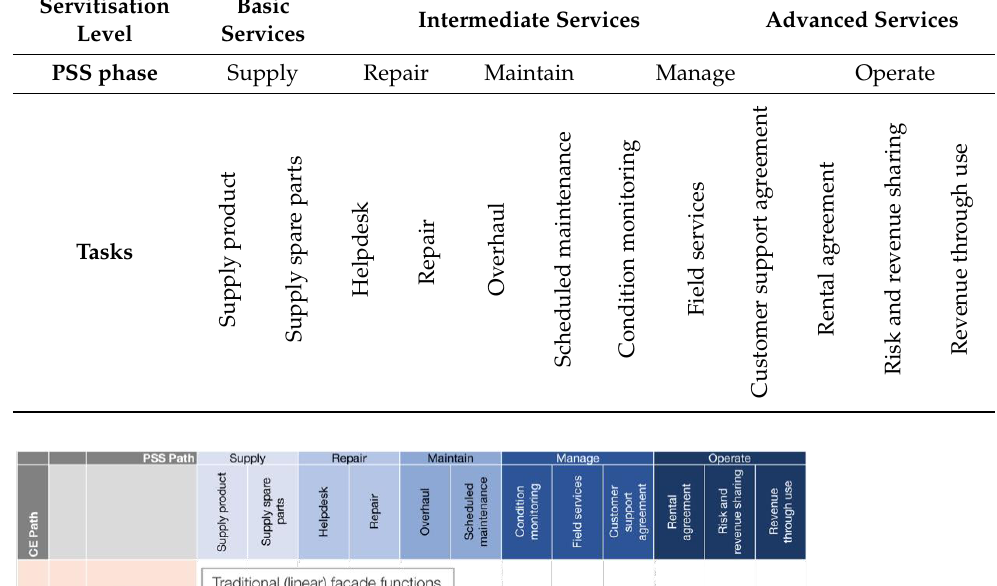
Table 2. Incremental servitisation process. Adapted from Baines & Lightfoot [20]. Servitisation Basic Intermediate Services Advanced Services Level Services